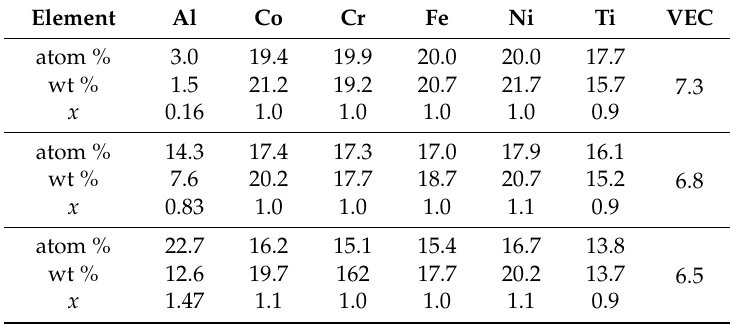
Table 3. Average chemical compositions of the three sets of samples measured by EDS.